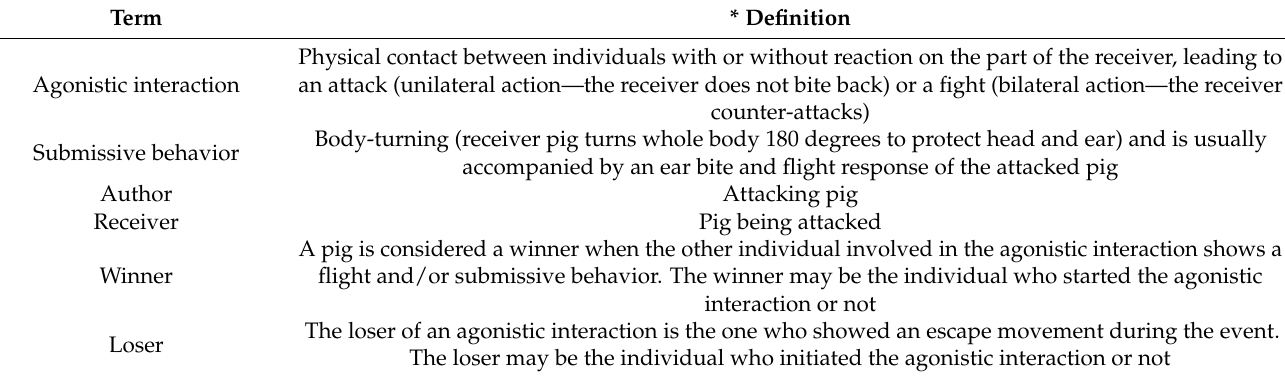
Table 1. Definition of the ethological patterns